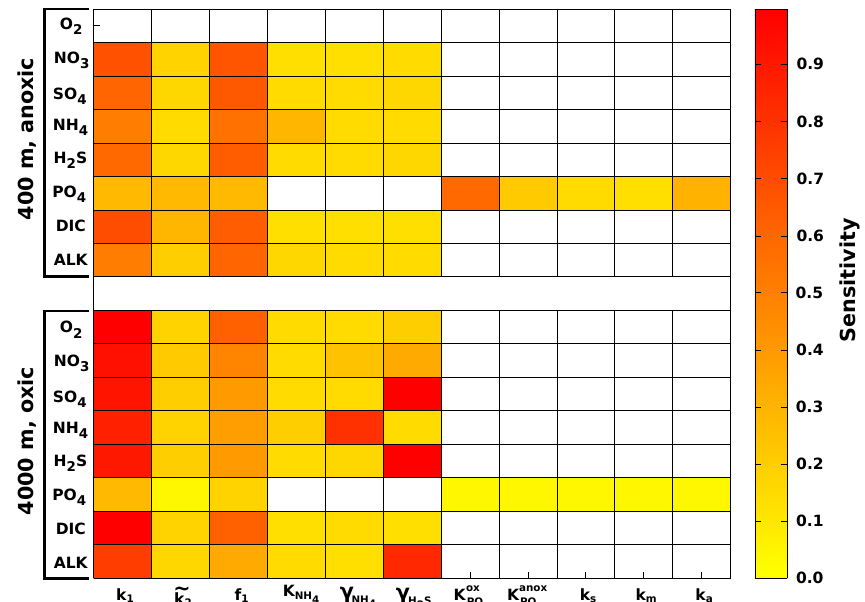
Figure 5. Pattern plot showing the output sensitivity for each SWI flux (i.e. the chemical compounds on the vertical axis) and each input factor (i.e. the model parameters on the horizontal axis) for two idealised sediment cores. White patterns are assigned where the SWI flux is independent of the specific